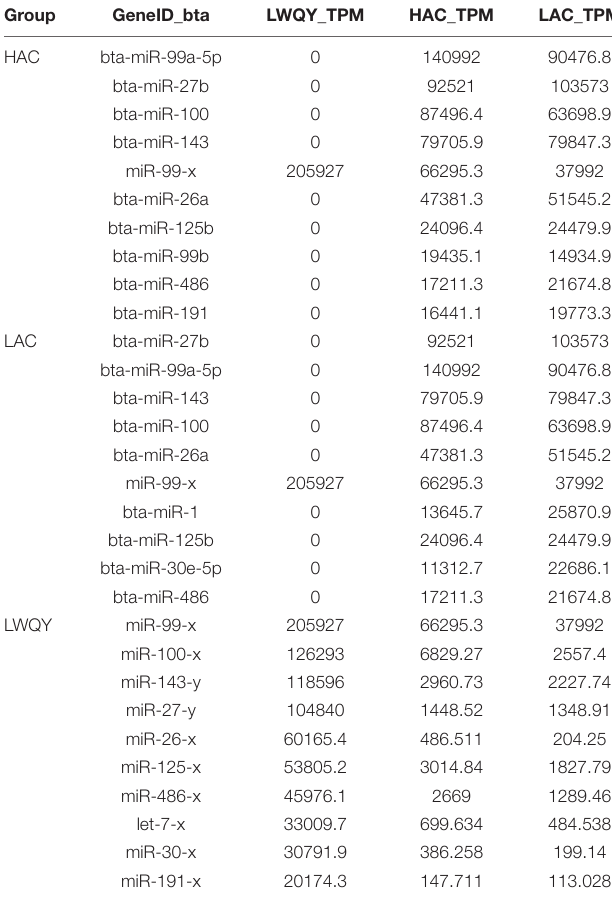
TABLE 2 | The 10 miRNAs with the highest expression levels among the three groups.